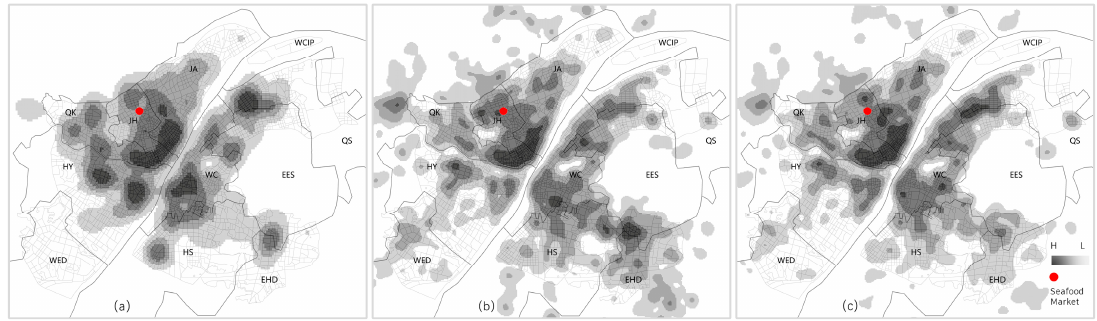
Figure 11. Kernel density analysis: ( a ) COVID-19 cases by Weibo data; ( b ) population density; and ( c ) the elderly population density generated by mobile phone data .